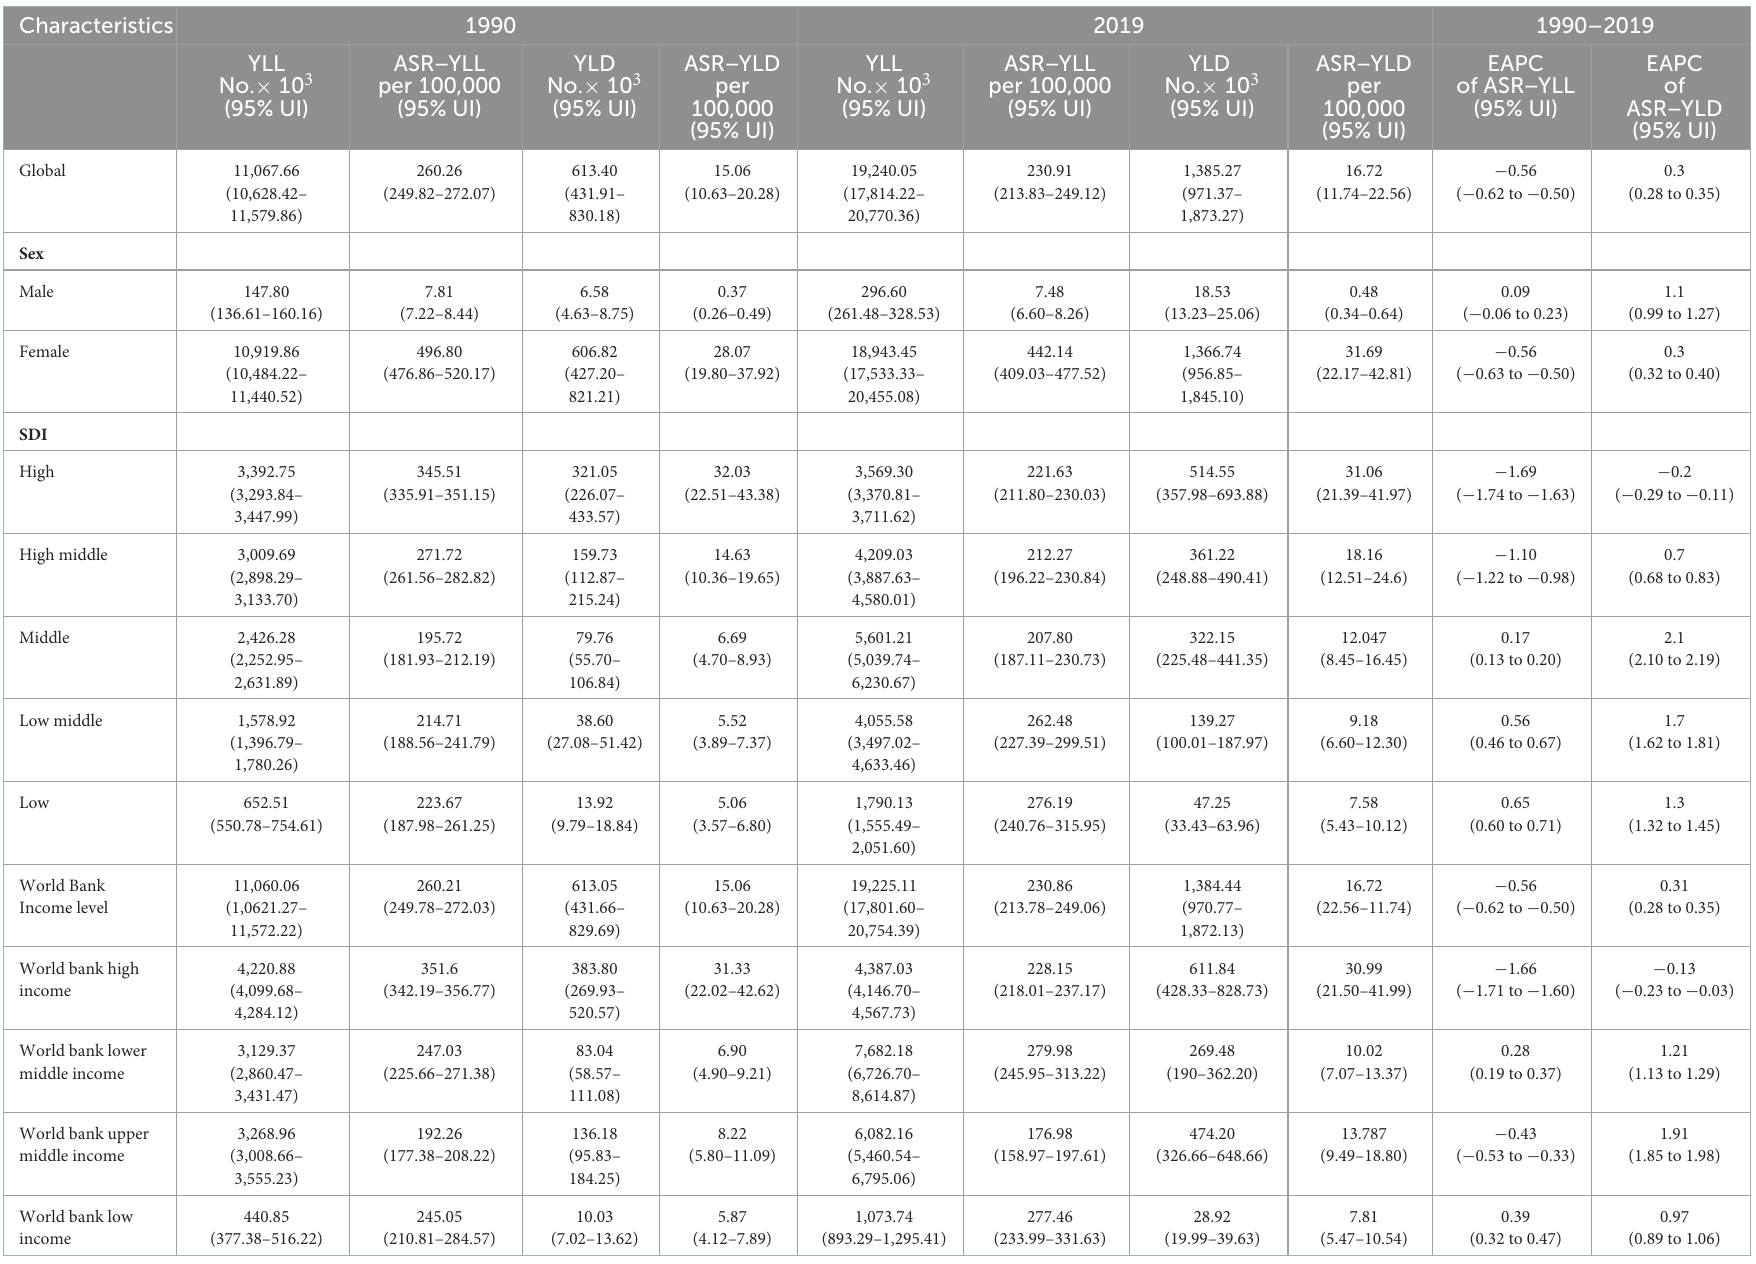
TABLE 3 The cases number of years of life lost years lived with disability and their age-standardized rates of breast cancer in 1990 and 2019, and its temporal trends from 1990 to 2019.